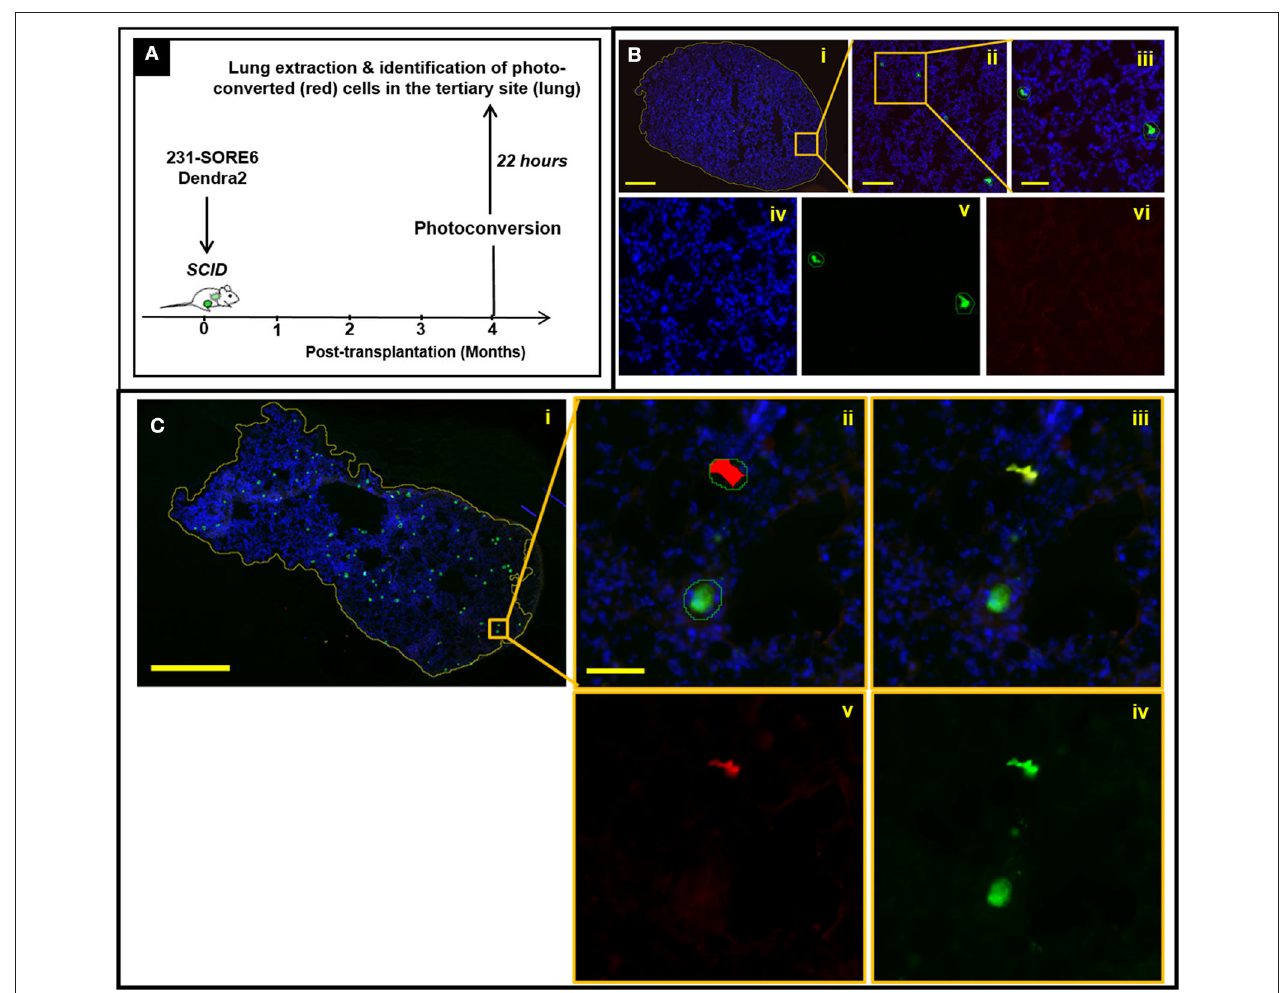
FIGURE 3 | Disseminated tumor cells (DTCs) in the lungs originate from established lymph node metastases in breast cancer xenografts. (A) Experimental design of disseminated tumor cell tracking analysis (mice sacrificed 22h after photoconversion). (B) Absence of photoconverted cells in fixed frozen sections of lung tissue from mice with negative lymph nodes. (i) Fixed-frozen sections of lung tissue were scanned on a digital whole slide scanner and then loaded into Visiopharm. The first of three apps identifies the boundaries of the tissue (yellow outline around tissue section). Scale bar = 1mm. (ii) Zoomed image of the region indicated by the orange box in (i). The second app identifies both unconverted and photoconverted cells (outlined with green lines). Scale bar = 200 µ m. (iii) Further zoom-in of the region indicated by the orange box in (ii). Scale bar = 50 µ m. (iv–vi) Individual DAPI (iv), green (v), and red (vi) fluorescence channels of the image shown in (iii). The third and final app identifies which of these cells are photoconverted, as indicated by the red overlay in (vi). The identification of cells as tumor cells is confirmed by the green fluorescence of the unconverted cells (v), while yellow fluorescence (red plus green) would be expected in the photo-converted cells because they show both Dendra2 colors. The isolated green channel in (v) shows both photoconverted and unconverted tumor cells. The isolated red channel in (vi) shows only cells which have been photoconverted. As expected however, no photoconverted cells are observed in mice with lymph nodes that are negative for tumor cells, indicating that photoconversion of tumor cells in the lymph node is indeed specific to the lymph nodes. (C) Presence of photoconverted cells in fixed frozen sections of lung tissue from mice with positive lymph nodes. (i) Fixed-frozen sections of lung tissue were scanned on a digital whole slide scanner and then loaded into Visiopharm. The first of three apps identifies the boundaries of the tissue (yellow outline around tissue section); (ii) Zoomed image of the region indicated by the orange box in (i); the second app identifies all photoconverted and unconverted cells (outlined with green lines) and the third and final app identifies which of these cells are photoconverted (indicated by the red overlay); (iii) Identification of cells as tumor cells is confirmed by the green fluorescence of the unconverted cells, and the yellow fluorescence (red plus green) of the converted cells; (iv) The isolated green channel shows all tumor cells; (v) The isolated red channel shows only cells which have been